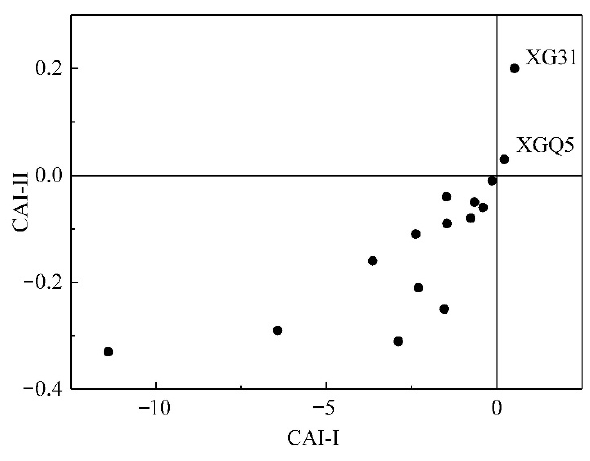
Figure 3. Diagram of chloro-alkaline indices.4.4.2. Dissolution of Carbonate